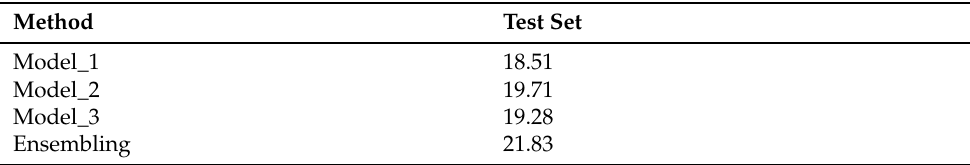
Table 4. The competition accuracy results of the proposed